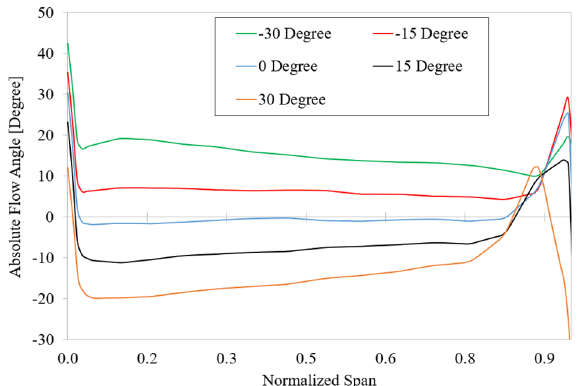
Figure 21. Absolute flow angle at leading edge of the impeller in different IGV’s setting angles.